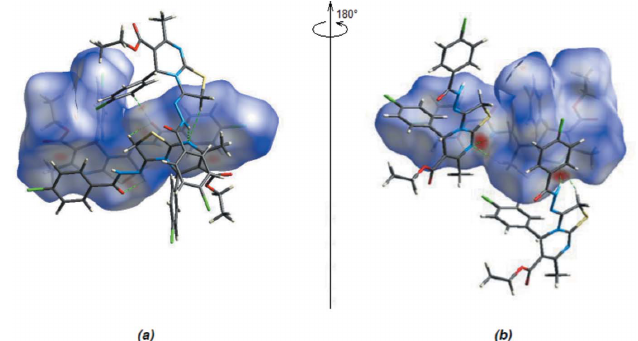
Figure 5 ( a ) Front view and ( b ) back view of the three-dimensional Hirshfeld surface of the title compound plotted over d norm in the range (cid:4) 0.4486 to +1.3171 a.u.